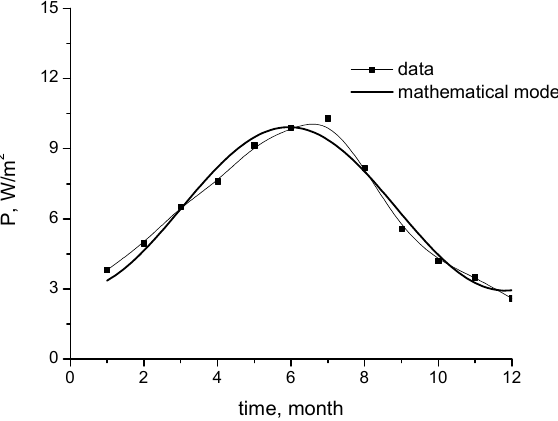
Figure 8. Relationship between monthly moving average data and the mathematical model.